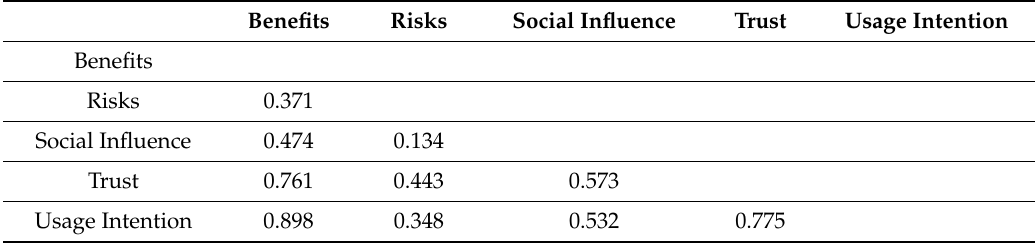
Table 4. Discriminant validity heterotrait-monotrait (HTMT)